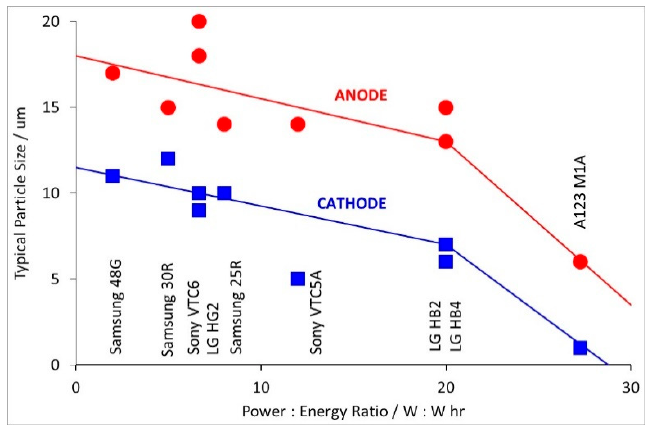
Figure 10. Correlation between active material particle sizes and power – energy ratios.